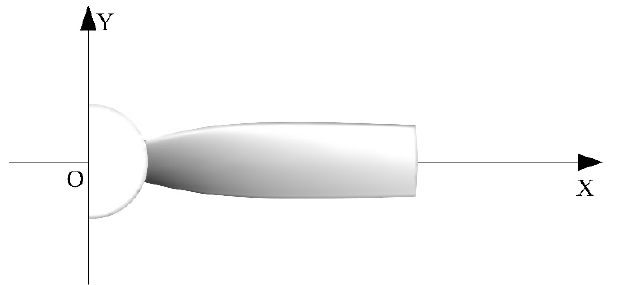
Figure 7. Axis system of the propeller.